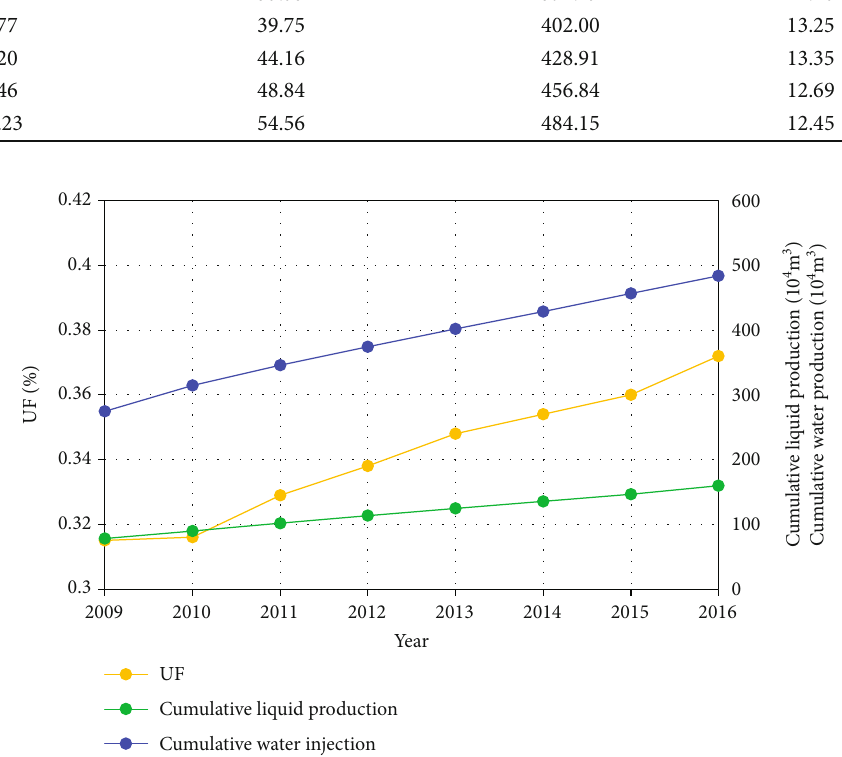
Figure 4: UF of water injection in this block from 2009 to